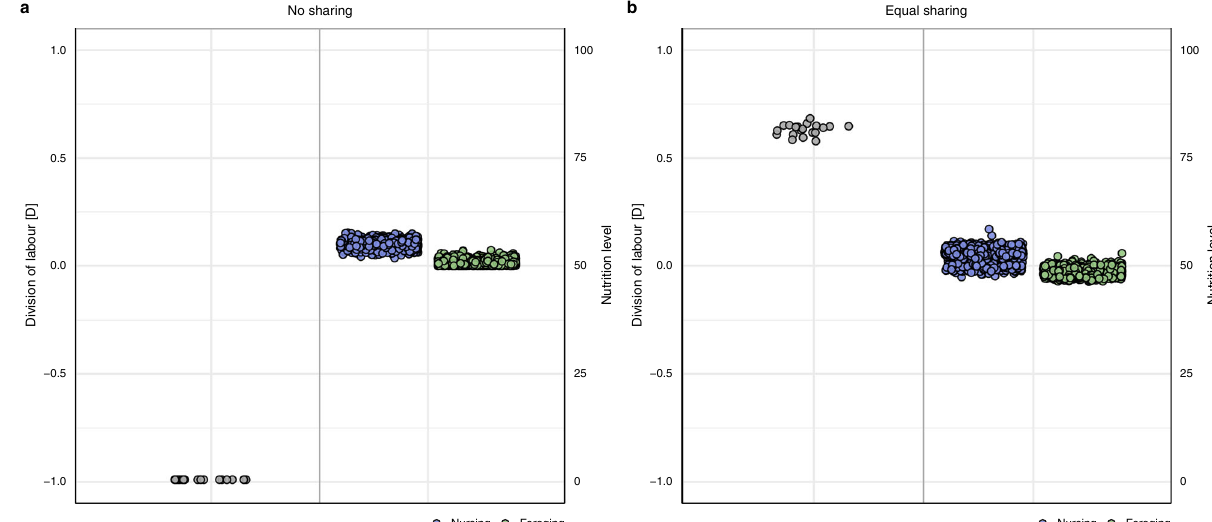
Fig. 2 | Division of labour and nutrition levels of nursing and foraging indivi- dualsundernoresourcesharingandequalsharing.a Nosharing.Intheabsence of resource sharing, D = − 1 which indicates that individuals alternate between nursing and foraging. As foraging is triggered by a decline in the nutrition level, nursing individuals have a higher nutrition level than foragers. b Equal sharing. If